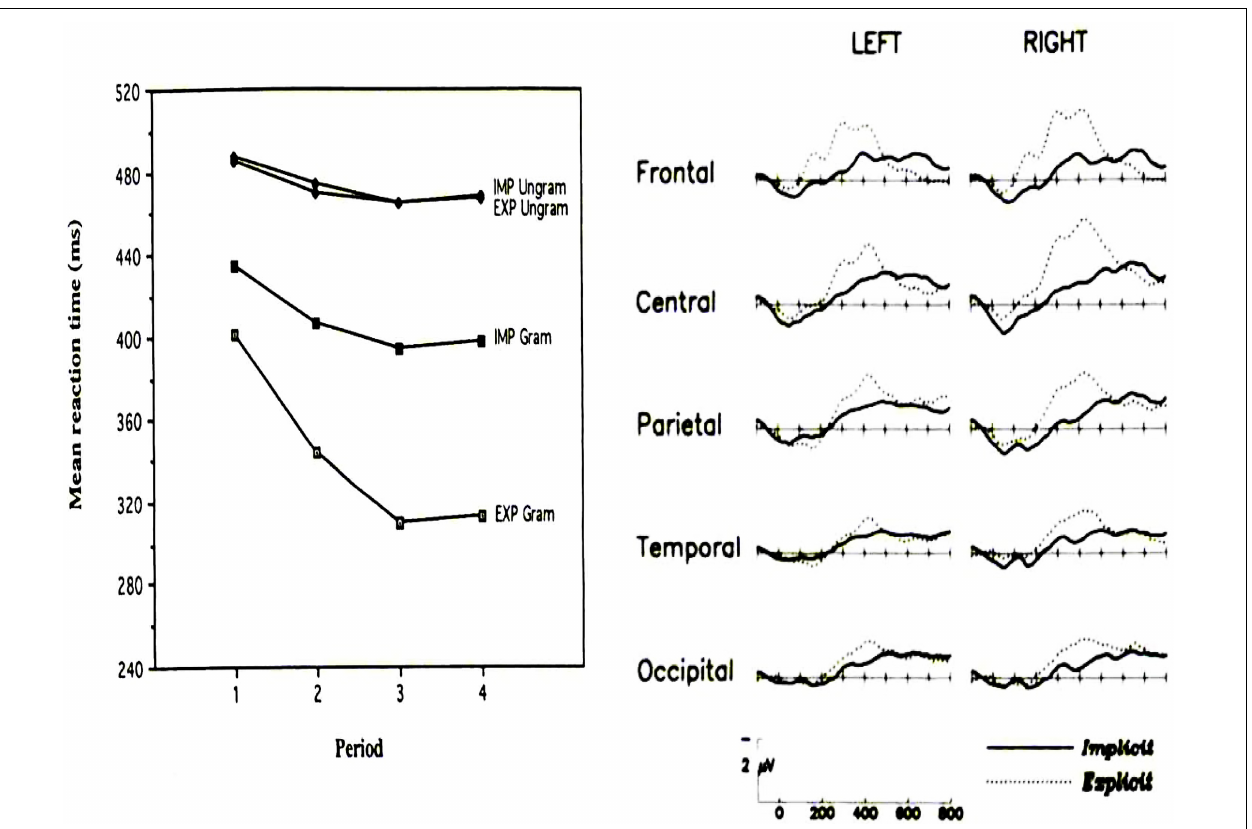
FIGURE 8 | Left panel: Mean response time to a SRT for grammatical (“Gram”) and ungrammatical (“Ungram”) sequences across practice sessions (each session lasts for four hours) under implicit (“IMP,” participants were not previously informed of the sequence structure) and explicit